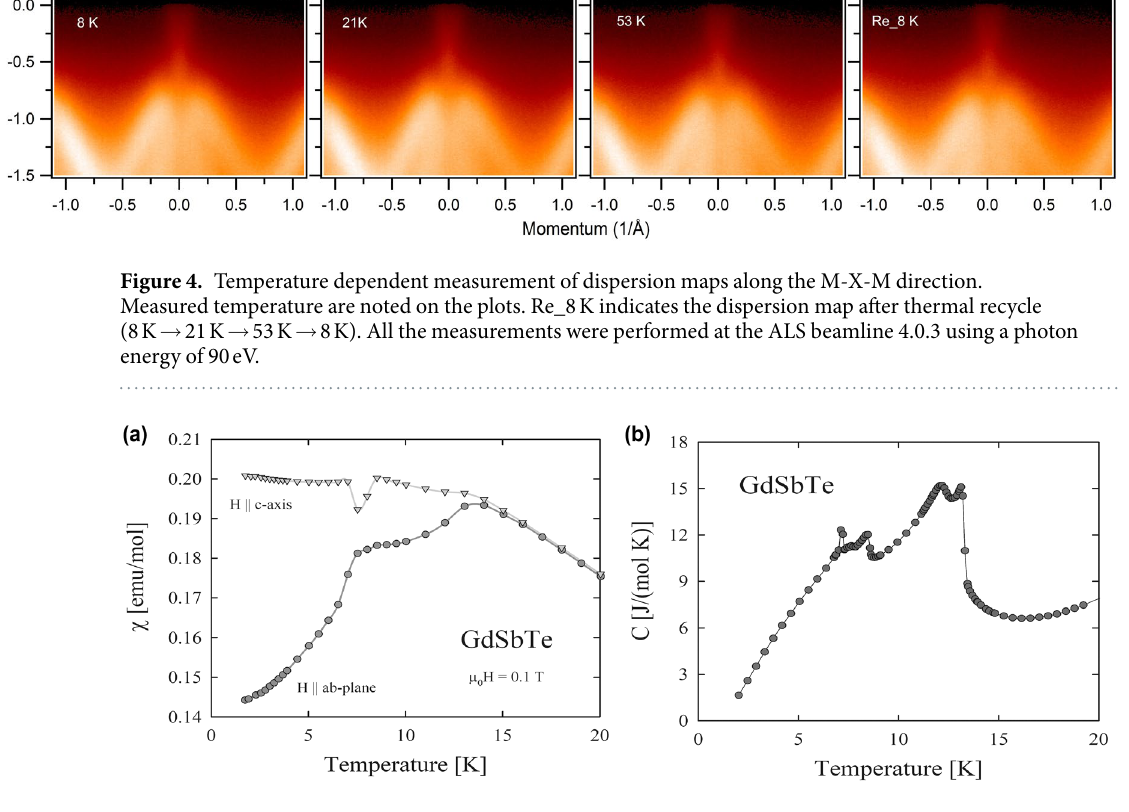
Figure 5. Low-temperature thermodynamic properties of single-crystalline GdSbTe. ( a ) Temperature dependence of the magnetic susceptibility measured in a magnetic field of 0.1 T applied along the crystallographic c axis (triangles) and the tetragonal a – b plane (circles). ( b ) Temperature dependence of the specific